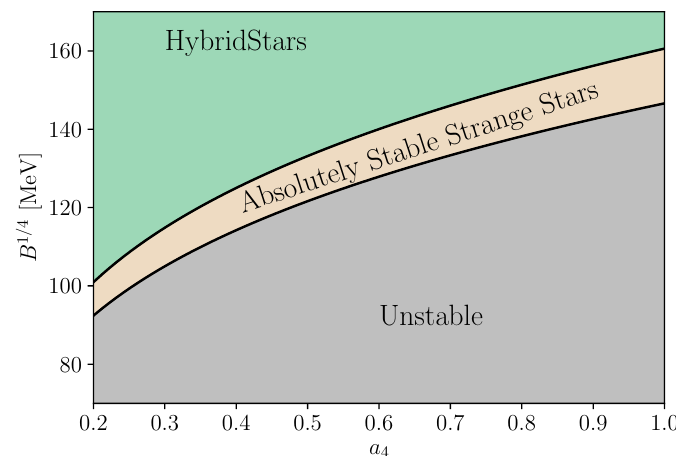
Figure 1. Parameter space ( a 4 , B ) for fixed a 2 = 5000 MeV 2 . We identify three different regions. The upper region where HM → SQM transitions are possible and describes a HyS. The middle region where SQM is absolutely stable and we found strange stars. The lower region is prohibited due to the instability of